Question: How would you classify this visualization?
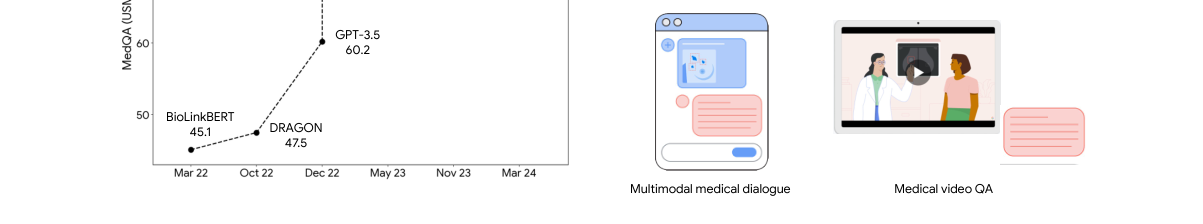
Answer: bar